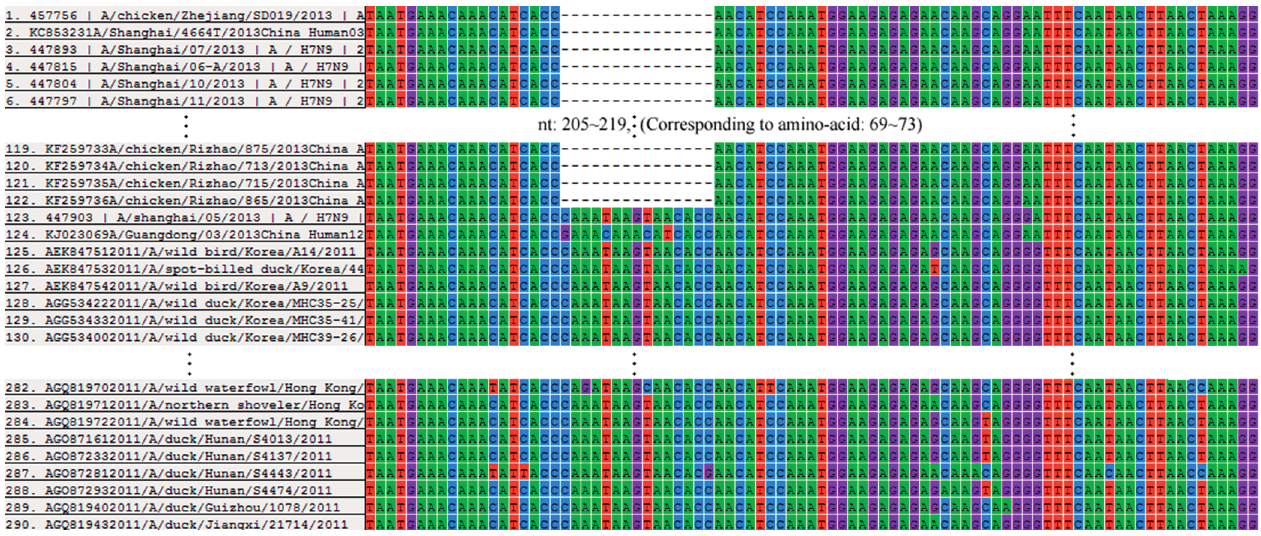
Figure 1. The alignment of N9 sequences affiliated to novel AIVs H7N9 and other subtypes. Only displayed the comparison between novel AIVs H7N9 and the isolates established during 1 January 2011–31 December 2011 in Asia. Sequences to be longer than 1000nt are